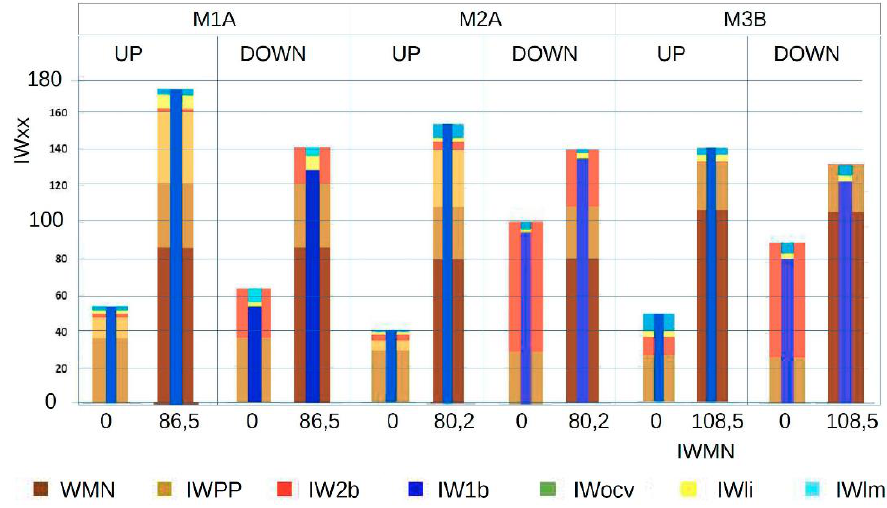
Figure 6. A graphic representation of the energy balance.